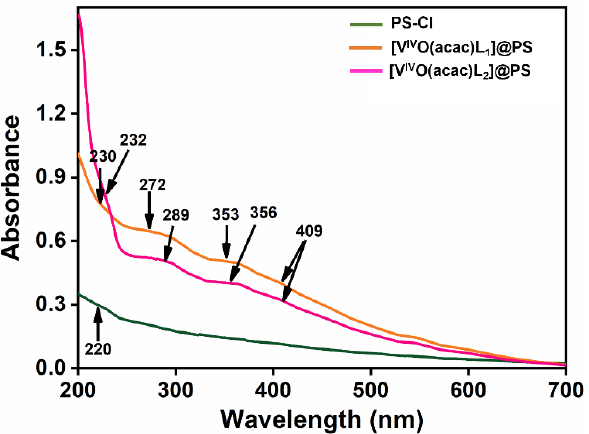
Figure 11. UV-visible spectra of PS-Cl, [V IV (acac)L 1 ]@PS ( 3 ) and [V IV (acac)L 2 ]@PS ( 4 ) recorded in Nujol.